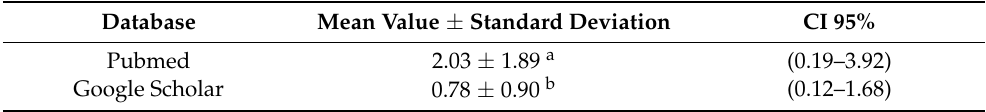
Legend: CI indicates confidence interval. Different letters indicate statistically significant differences between